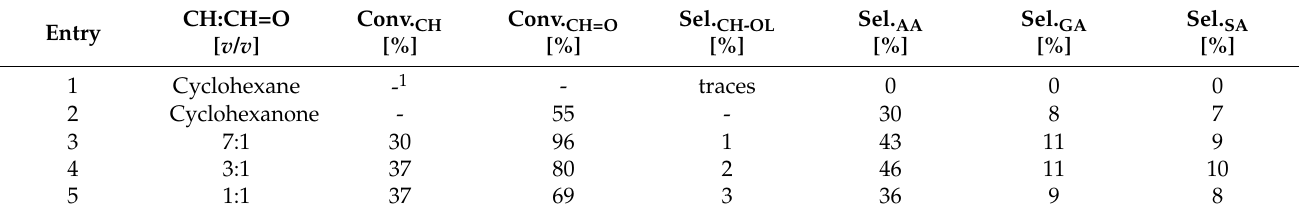
Table 3. The influence of CH/CH=O ratio on the oxidation reaction.